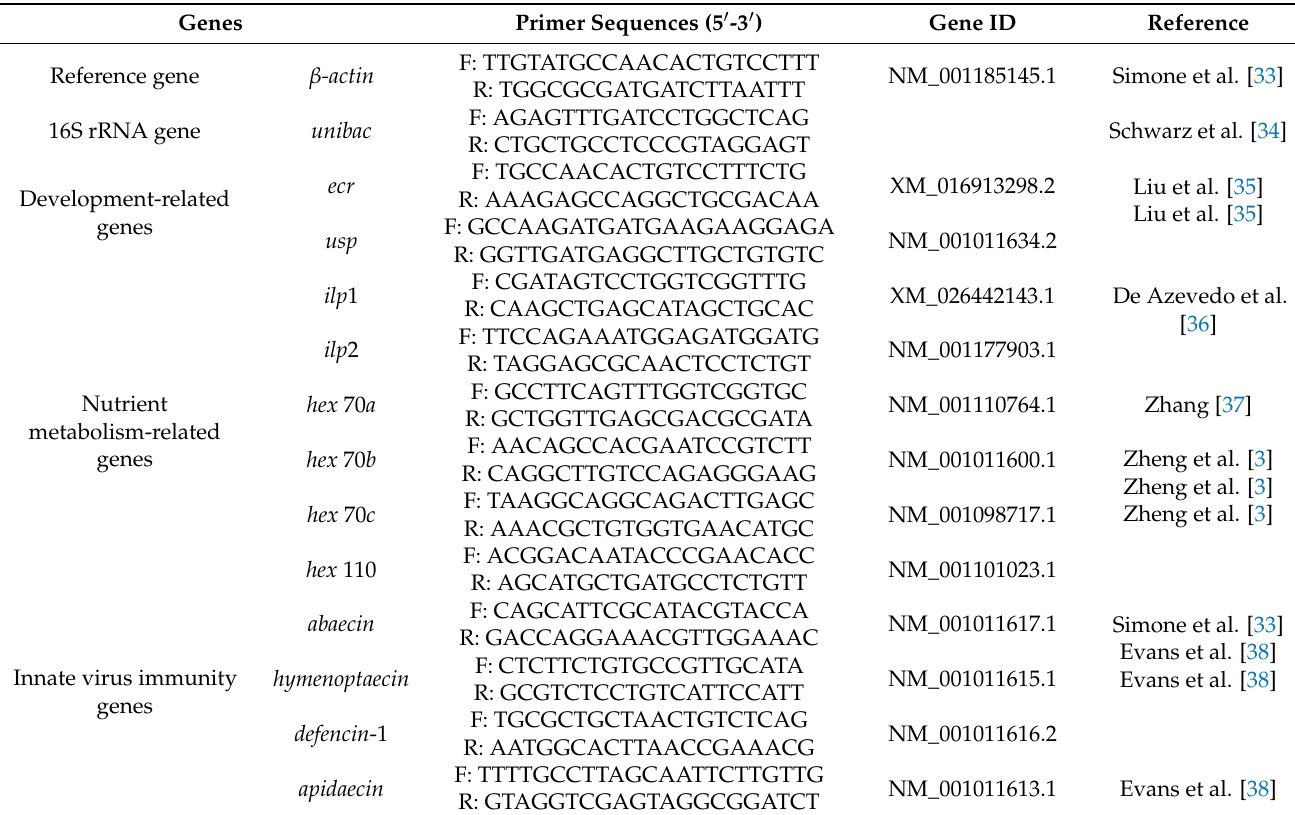
Table 1. Primers used for quantitative